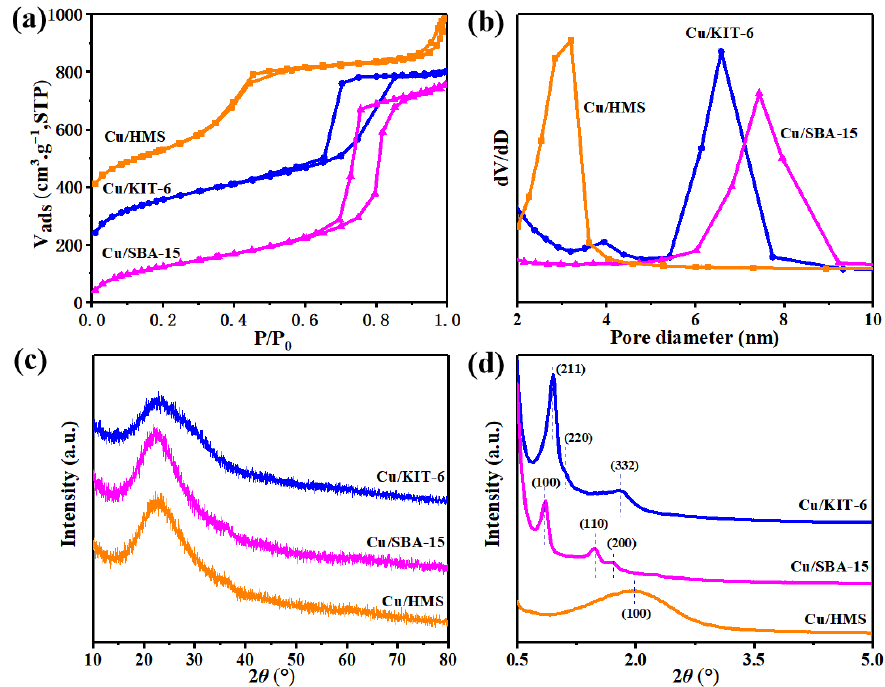
Figure 2. ( a ) Nitrogen adsorption isotherms, ( b ) pore size distributions, ( c ) wide-angle, and ( d ) small-angle XRD patterns, of Cu/KIT-6, Cu/SBA-15, and Cu/HMS catalysts. Table 1. The texture structure and catalytic activities of the investigated